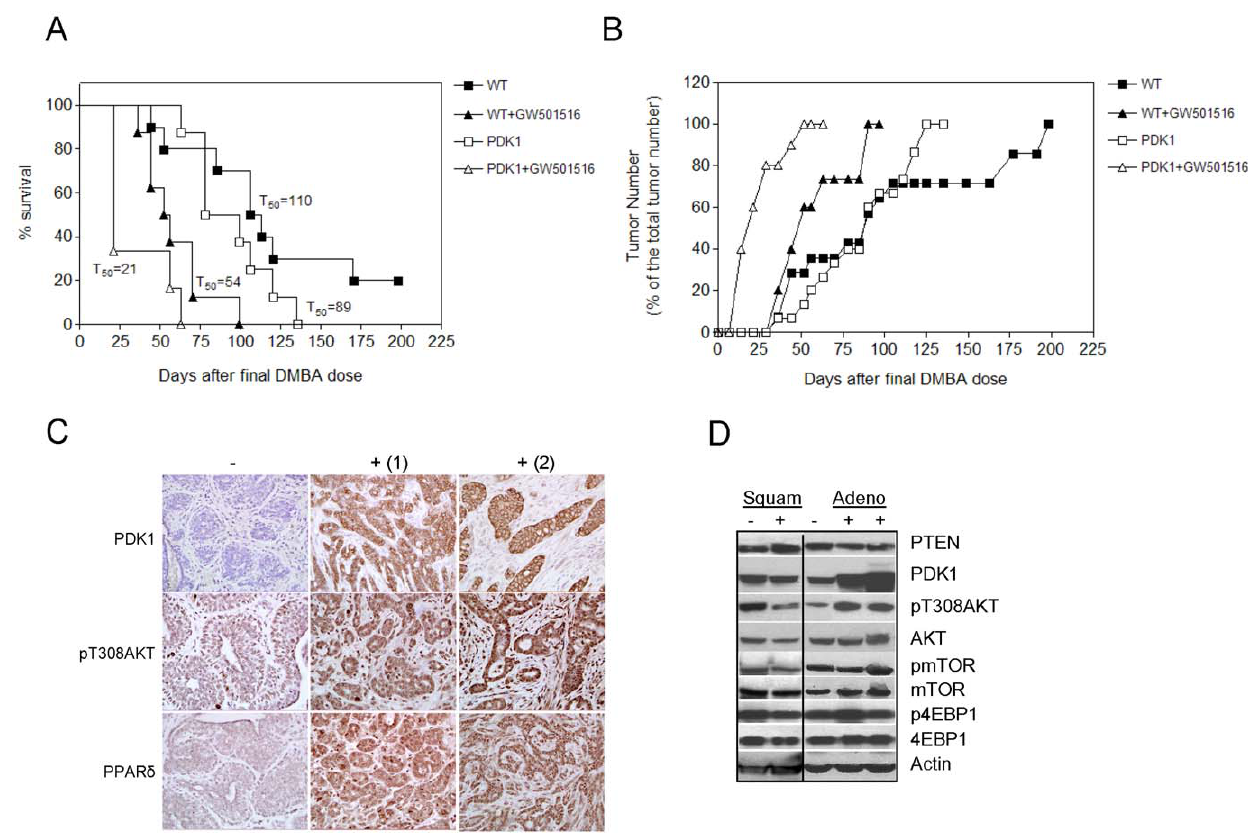
Figure 2. GW501516 enhances DMBA-induced mammary carcinogenesis. (A) Following medroxyprogesterone/DMBA treatment, tumor latency was similar between MMTV-PDK1 mice and wild-type littermates, but was reduced in both groups by treatment with the PPAR d agonist GW501516. Survival is defined as the time at which tumors reached , 1000 mm 3 and animals were euthanized. The median tumor-free interval ( T 50 ) was 89 days for MMTV-PDK1 mice ( PDK1 ) vs. 110 days for wild-type mice ( WT ) (P=0.1738); 54 days for GW501516-treated wild-type animals vs. 110 days for WT mice (P=0.0019); 21 days for GW501516-treated PDK1 mice vs. PDK1 mice (P=0.0002). Statistical analysis used the log rank test. The number (N) of mice per group was: WT (N=10), WT + GW (N=10), PDK1 (N=8), PDK1 + GW (N=6). (B) Cumulative mammary tumor formation. The total number of tumors is expressed as a percentage of total tumor number. Percent tumor formation between GW501516-treated WT vs. WT mice ( P =0.0127), GW501516-treated PDK1 vs. PDK1 mice ( P =0.0011) and GW501516-treated PDK1 vs. WT mice ( P =0.0001 were statistically significant. Tumor formation in WT vs. PDK1 mice (P=0.710) was not significantly different. (C) IHC analysis indicates that PDK1, pT308AKT and PPAR d expression are increased in two adenocarcinomas from MMTV-PDK1 mice ( + ) vs. an adenocarcinoma from a wild-type littermate ( 2 ). Magnification 600 6 . (D) Immunoblot analysis indicates that PDK1 and pT308AKT are elevated in adenocarcinomas from MMTV-PDK1 mice ( + ) vs. wild-type mice ( 2 ), but were unchanged in squamous